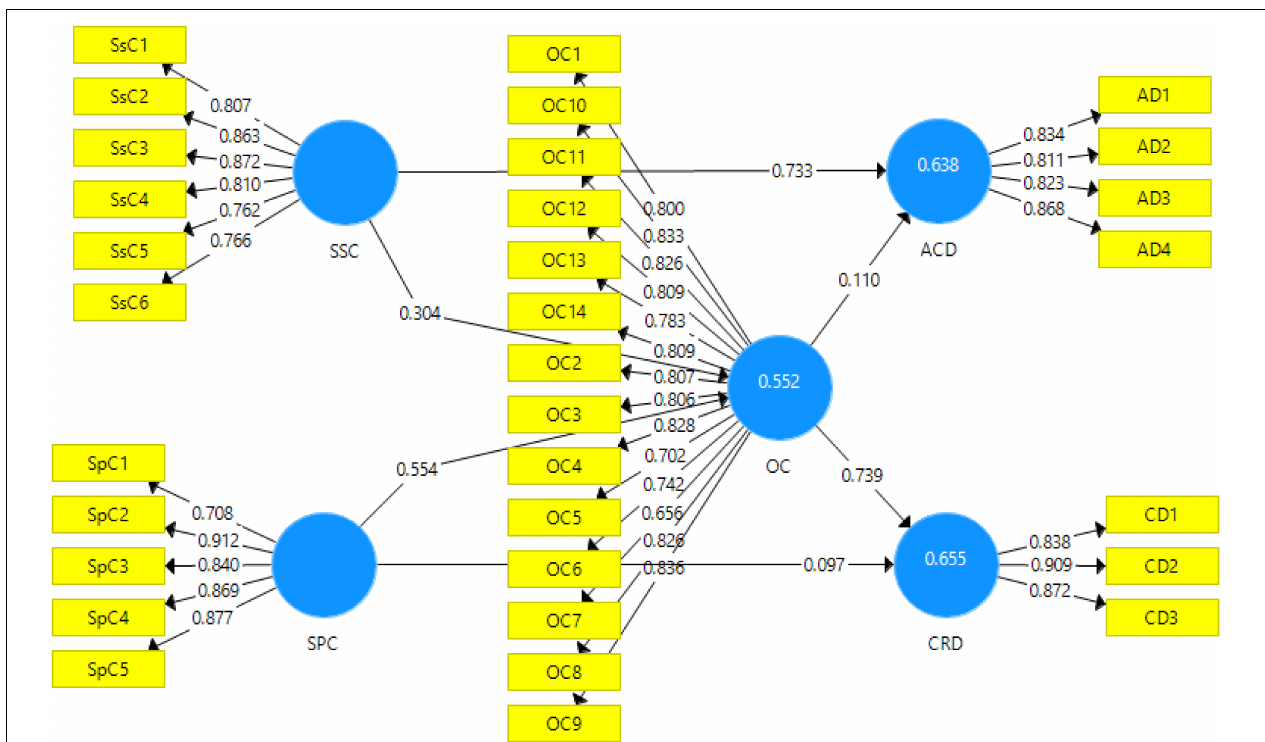
FIGURE 2 | Output of measurement model algorithm. SSC, social skills coaching; SPC, sports coaching; ACD, academic development; CRD, career development; OC, organizational